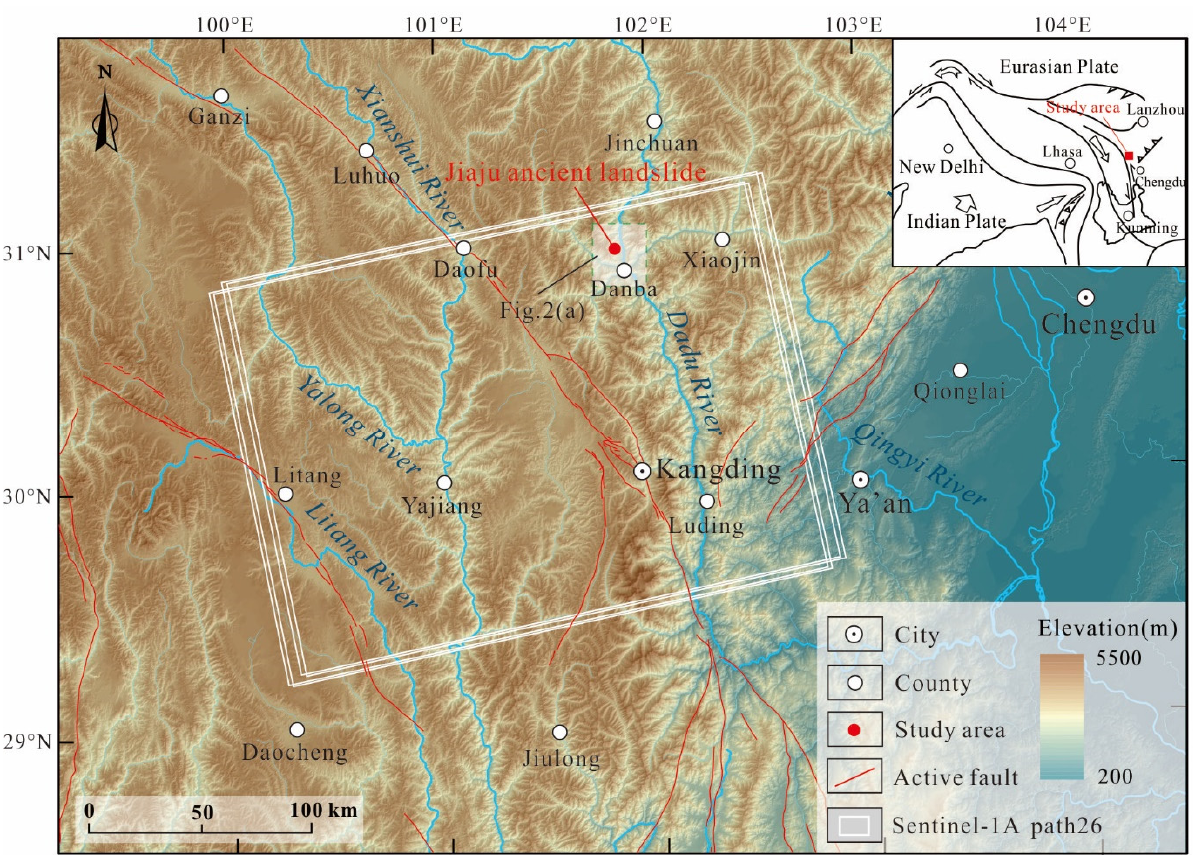
Figure 1. The Jiaju ancient landslide location and the Sentinel ‐ 1A ascending data coverage map.